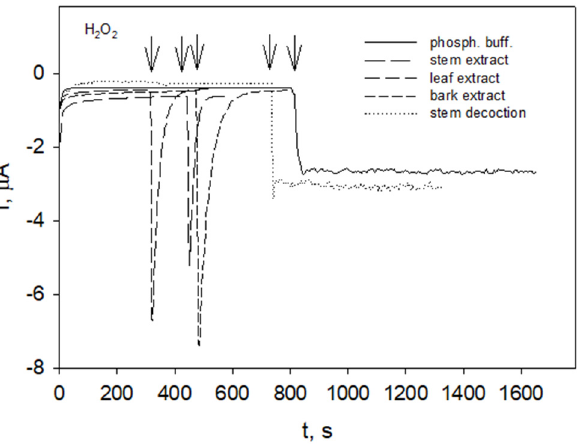
Figure 4. Responses of GC/PB in phosphate buffer pH 6 and various R. idaeus extracts (as indicated) obtained at room temperature to the additions of H 2 O 2 , operating potential 0.0 V. Arrows indicate the moments of H 2 O 2 addition. Plant material (leaves and stems) collected in August and bark peeled from stems collected in December.